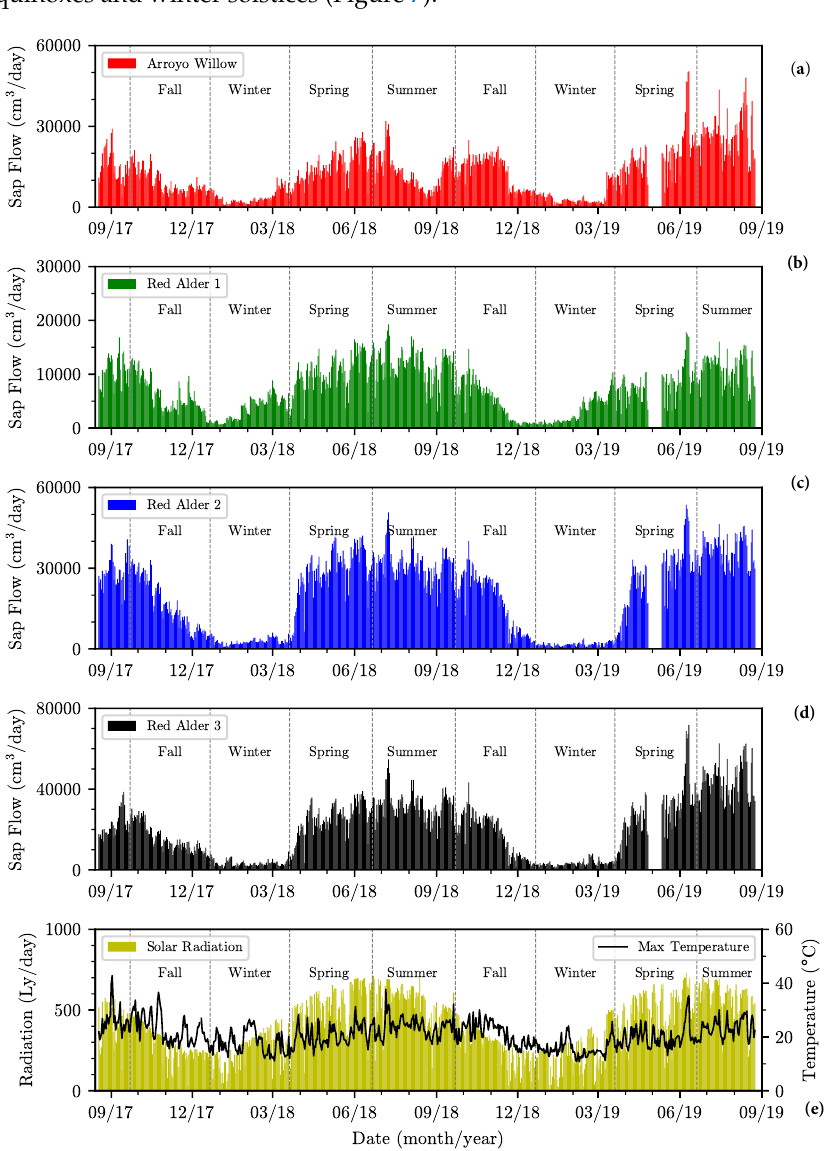
Figure 7. Daily total sap flow measured in ( a ) arroyo willow, ( b ) red alder 1, ( c ) red alder 2, ( d ) red alder 3, and ( e ) the CIMIS daily maximum air temperature and solar radiation over the monitoring